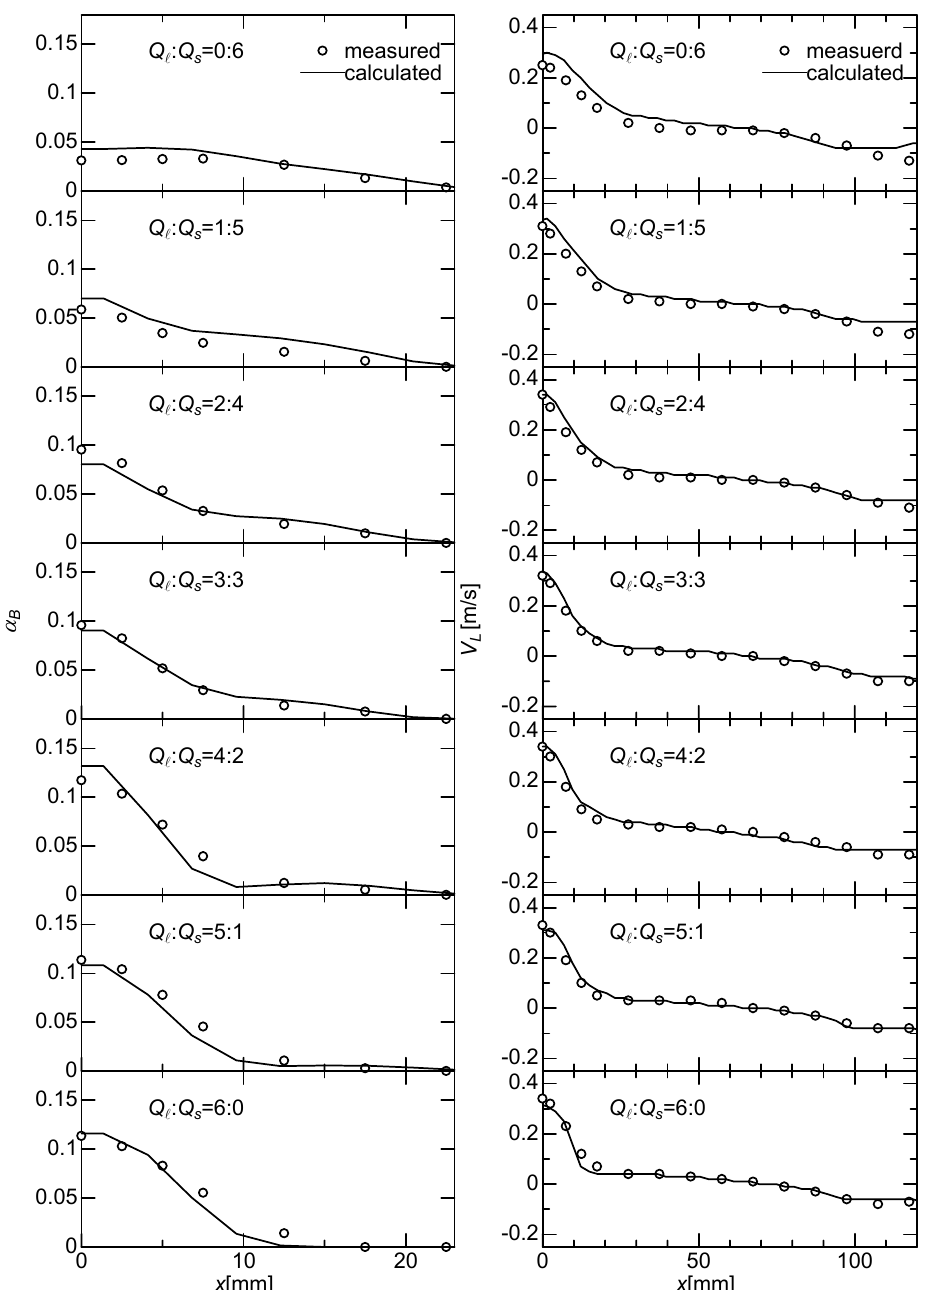
Fig. 7 Measured and predicted void fractions Fig. 8 Measured and predicted liquid